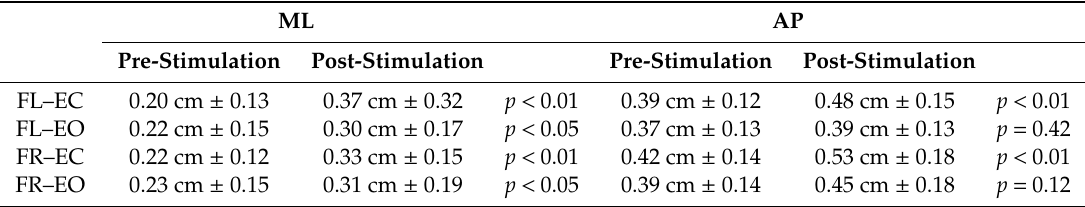
Table 1. Mean Sway (Standard Deviation of the CoP Sway ± SD) in the Frontal (ML) and Sagittal (AP) Planes. P Refers to the Post-Hoc Test